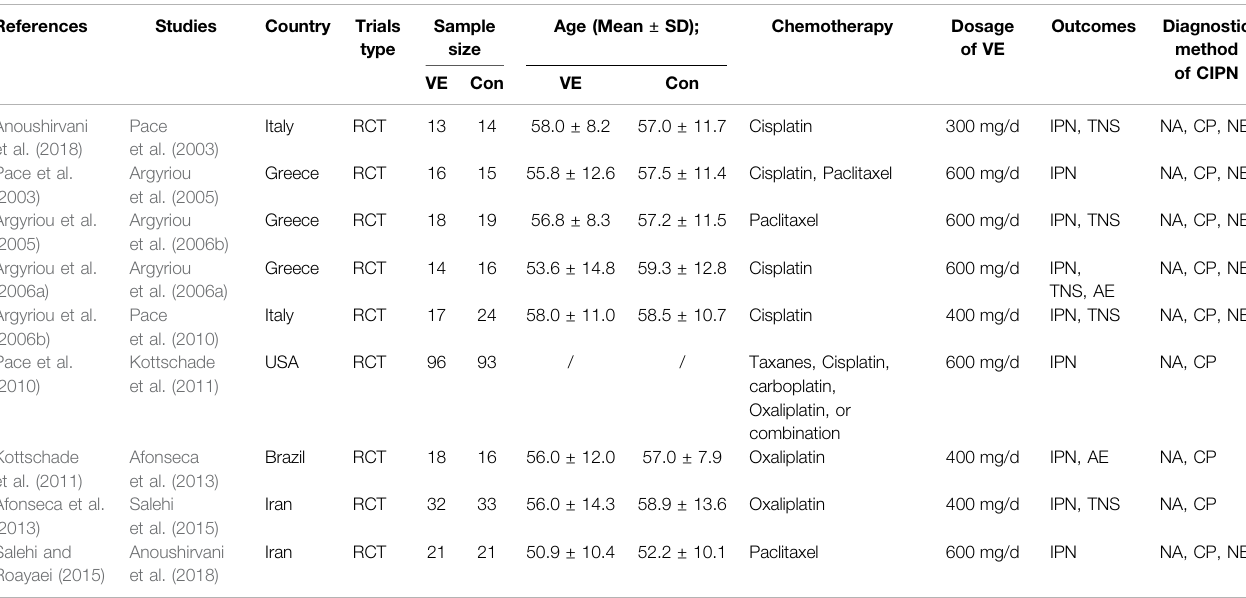
TABLE 1 | Characteristics of included